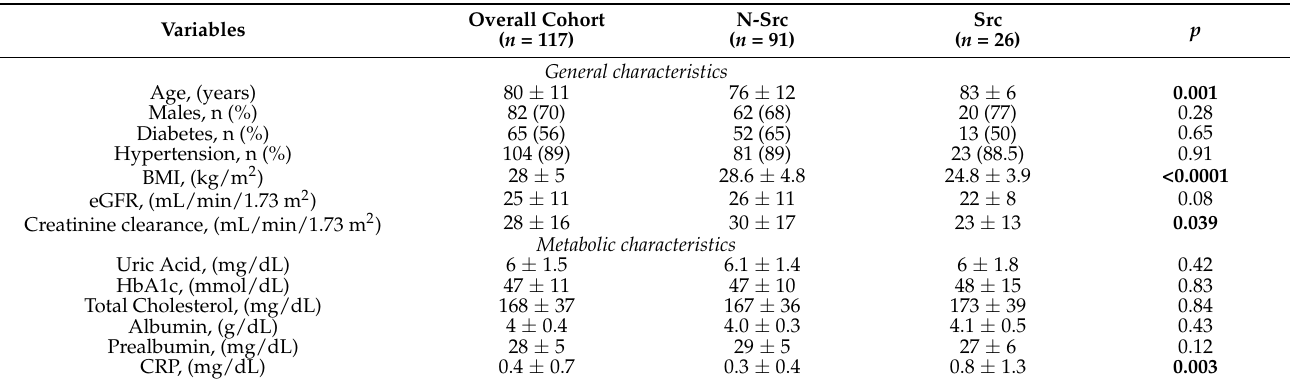
Table 1. Patients’ cohort characteristics.